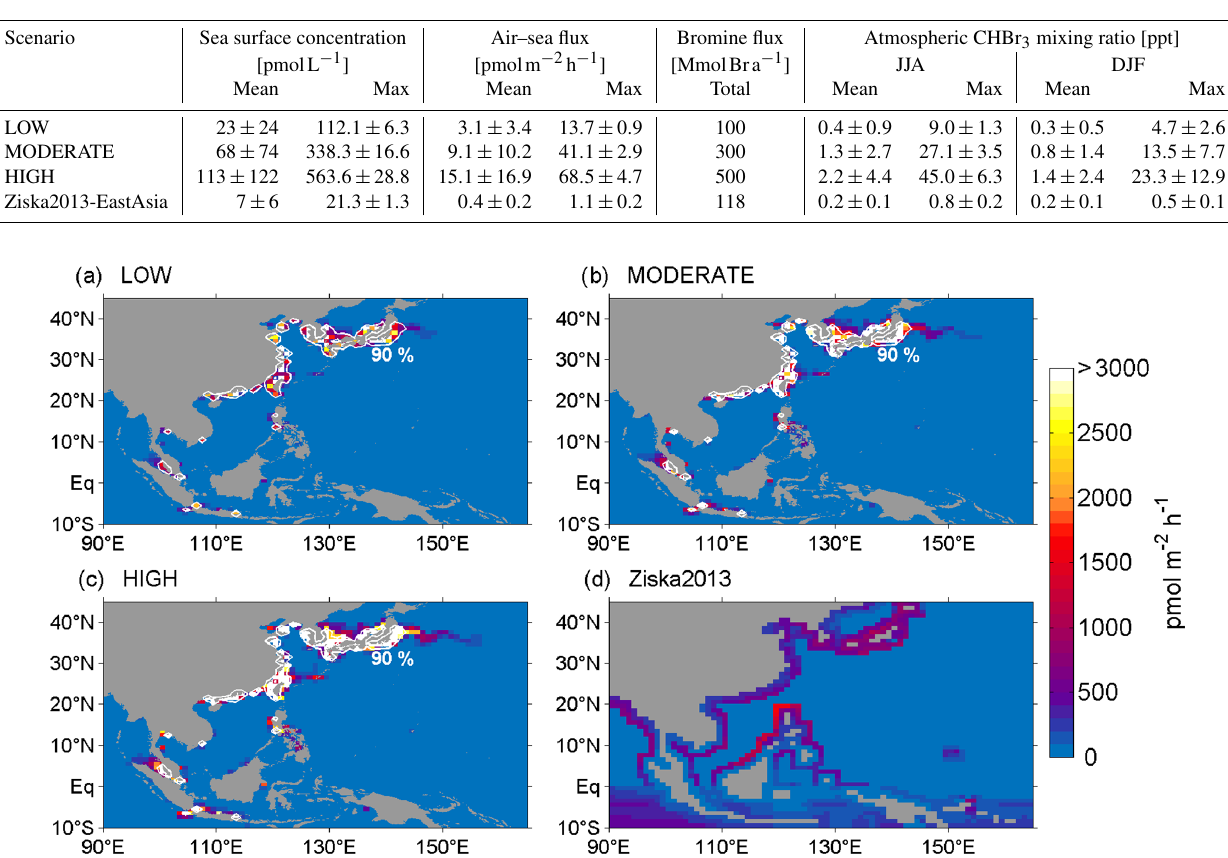
Table 2. Mean and maximum bromoform concentration [pmolL − 1 ] for the three Ariane runs LOW, MODERATE, and HIGH, as well as the climatological values from the Ziska2013 bottom-up estimate in East and Southeast Asia. Mean and maximum air–sea flux [pmolm − 2 h − 1 ] from the three scenarios and the Ziska2013 air–sea flux in East and Southeast Asia. The annual mean bromine flux [MmolBra − 1 ] is derived from the air–sea flux of the total domain in East and Southeast Asia. Mean and maximum atmospheric bromoform mixing ratios in the marine boundary layer [ppt] from the four FLEXPART runs. Values are given as the mean and the standard deviation averaged over the largest 90% (referred to as mean values) and over the largest 10% (referred to as maximum values).